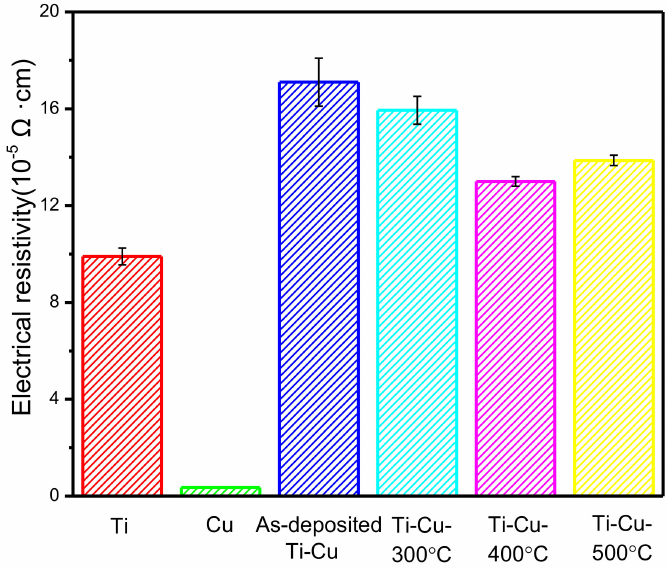
Figure 8. Resistivity of Ti, Cu, as-deposited Ti–Cu, and Ti–Cu coatings annealed at varied temperatures of 300 ◦ C, 400 ◦ C, and 500 ◦ C on silicon